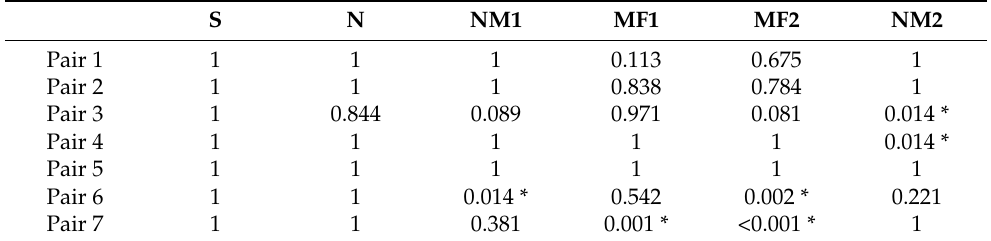
Table 3. Chi squared test p -values for Hardy–Weinberg equilibrium for the first seven chromosome pairs from each L. monticola chromosomal race (S: Southern; N: Northern; NM1: Northern Modified 1; MF1: Multiple Fissions 1; MF2: Multiple Fissions 2; NM2: Northern Modified 2). * p <